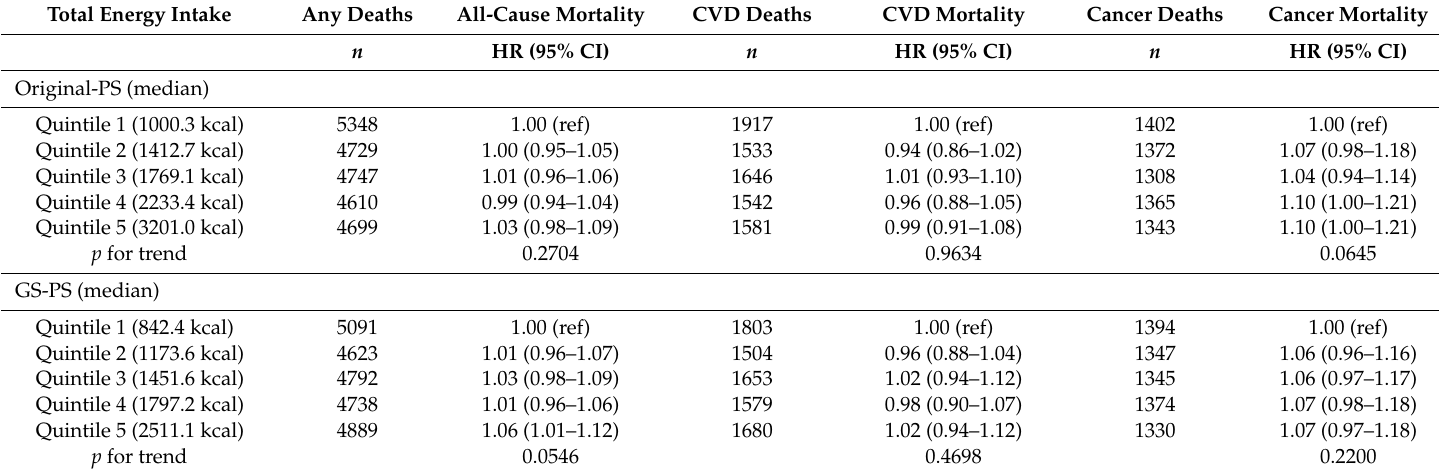
Table 3. Hazard ratios (HRs) (95% confidence intervals (CIs)) for all-causes, cardiovascular disease (CVD), and cancer mortality according to quintiles of total energy intake estimated from a food frequency questionnaire either using an original-portion size (Original-PS) or a gender specific-portion size (GS-PS) among women ( n = 86,292) in the Multiethnic Cohort Study, 1993–2014 1